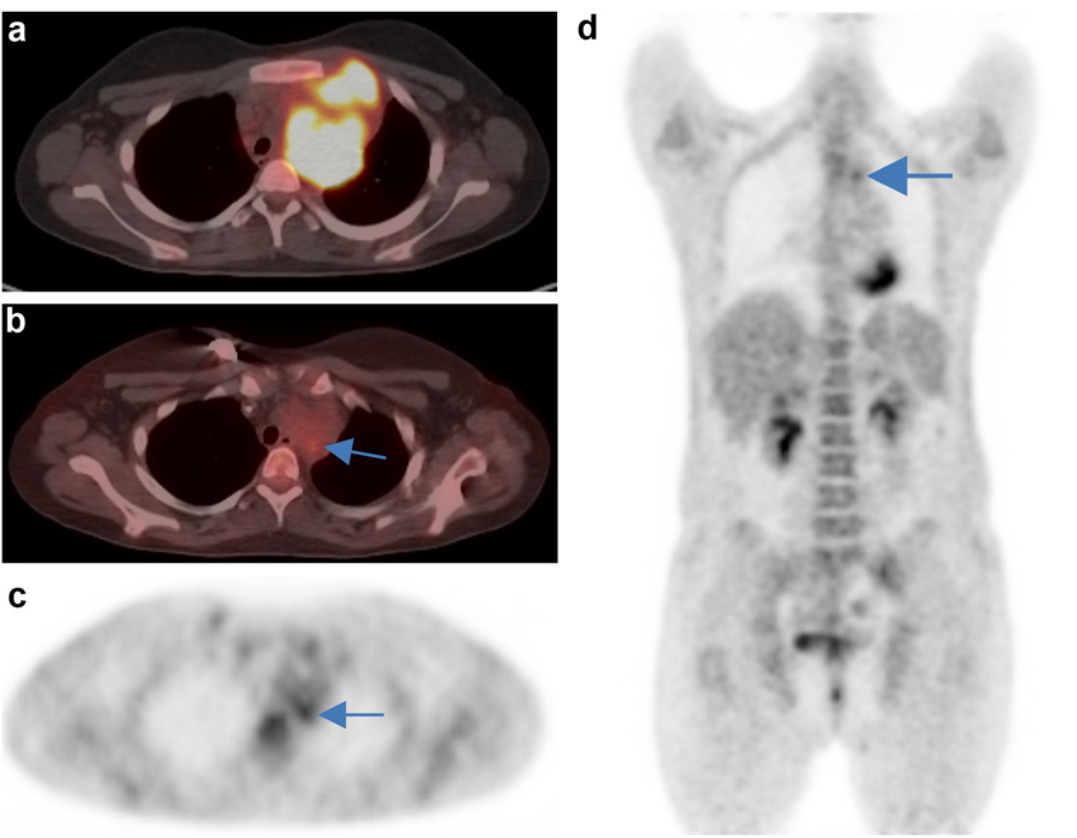
Fig 4. Discrepant D scoring of the mediastinum. Case 39: a) extensive lymphoma involvement of the left side of the upper mediastinum before treatment. b) residual mass after two cycles ChT. c) highest residual FDG uptake in the dorsal part of the residuum. D) It is difficult to decide if this highest FDG uptake is above or below the liver uptake. The interpretation is complicated by the small size of the hottest part of the residuum. Deauville score of the readers R1-5, respectively: 3-3-4-4-4. Courtesy M. Reinhardt, Dept. Nuclear Medicine, Pius-Hospital, Oldenburg, Germany.